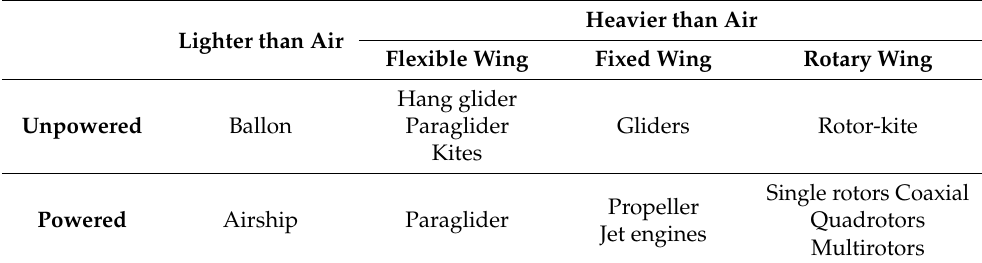
Table 2. Classification of UASs according to Eisenbeiss (2009) [30] and Eisenbeiss and Sauerbier (2011) [31].